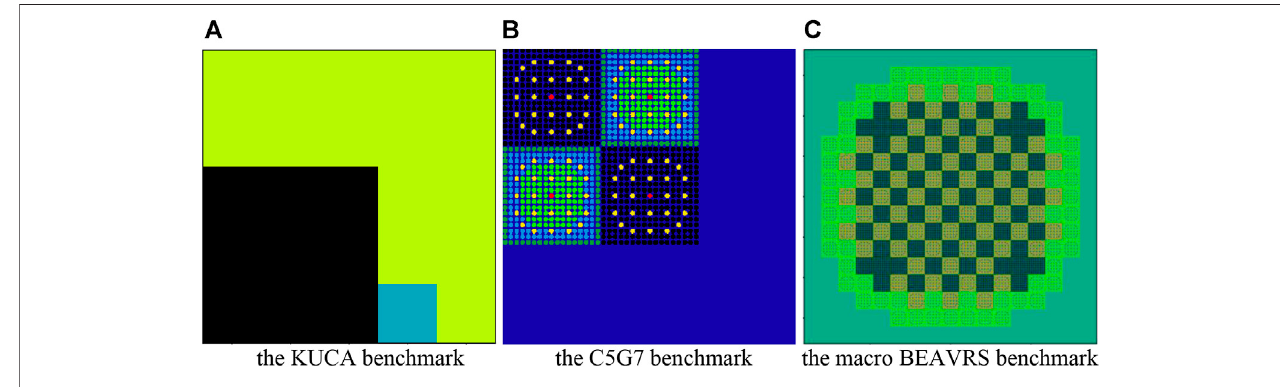
FIGURE 8 | Modeling of the pin-cell geometry cases with